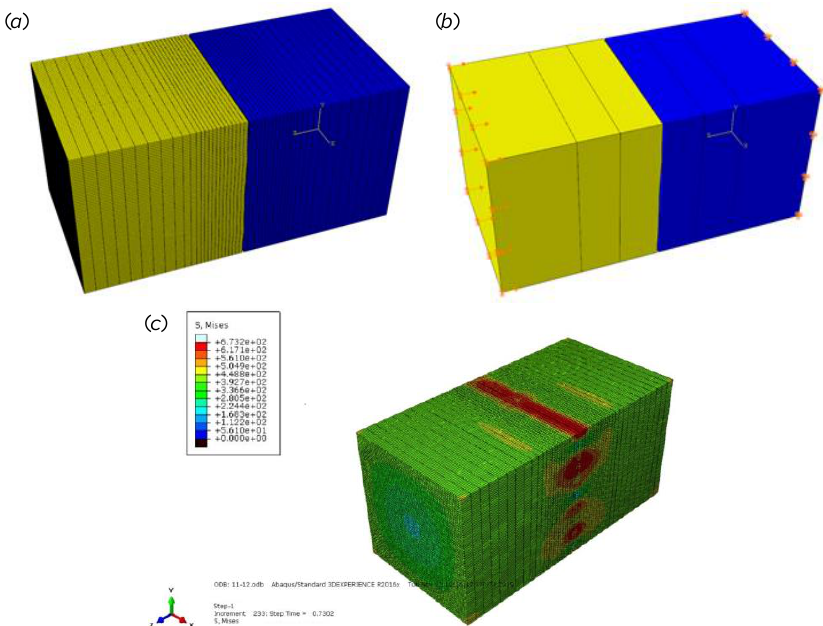
Figure 5. Finite element processing flow. ( a ) Meshing result; ( b ) Load application and boundary conditions; ( c ) Stress cloud diagram of the simulation result.